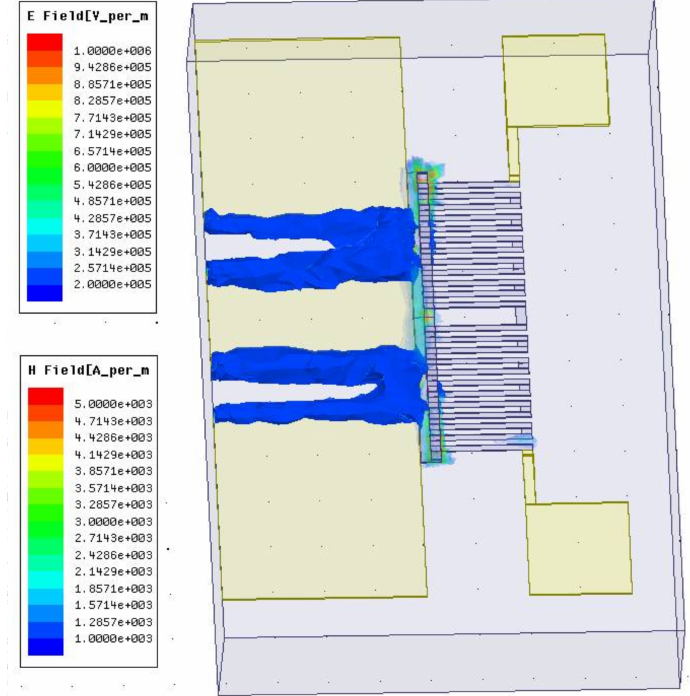
Figure 3. Simulated electromagnetic field distribution of the power sensor with the overlapping length of 10 µ m between the floating thermal slug and the